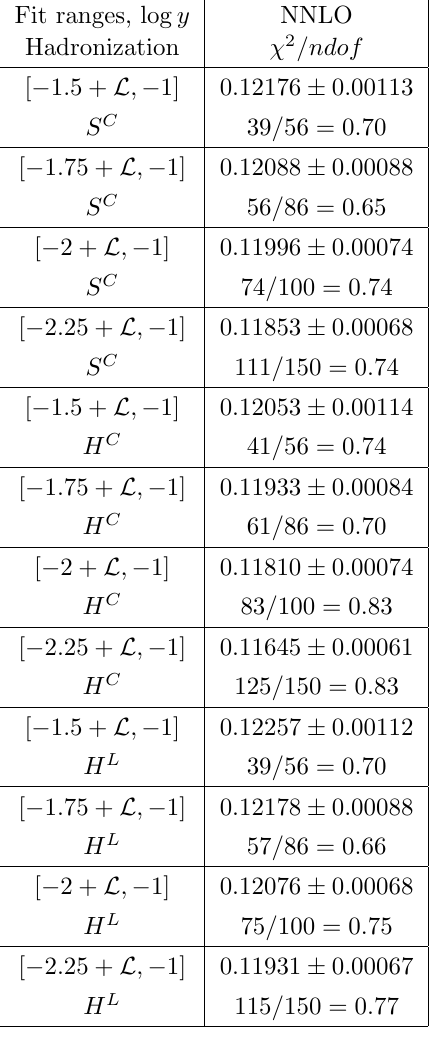
Table 5 . Fit of (cid:11) s ( M Z ) from experimental data for R 3 obtained using NNLO predictions, three di(cid:11)erent hadronization models and four di(cid:11)erent choices of the (cid:12)t range, as given in the brackets, where L = log ( M 2 =Q 2 ). The reported uncertainty is the (cid:12)t uncertainty only, as given by MINUIT2 10 Z